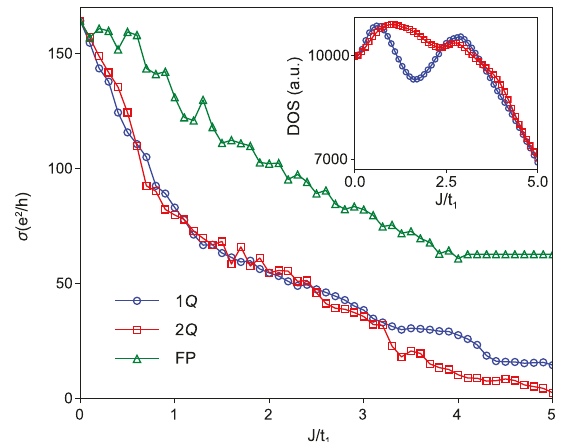
Fig. 5 Conductance vs J in different magnetic states and density of states of CeAuSb 2 . J / t 1 dependence of the conductance for the 1 Q (circles), 2 Q (squares), and fi eld polarized (FP) (triangles) states. Here, the conductance is averaged over domains with different Q orientations. Inset shows the density of state at the Fermi energy for the 1 Q (circles) and 2 Q (squares) states. Error bars are smaller than the size of the data